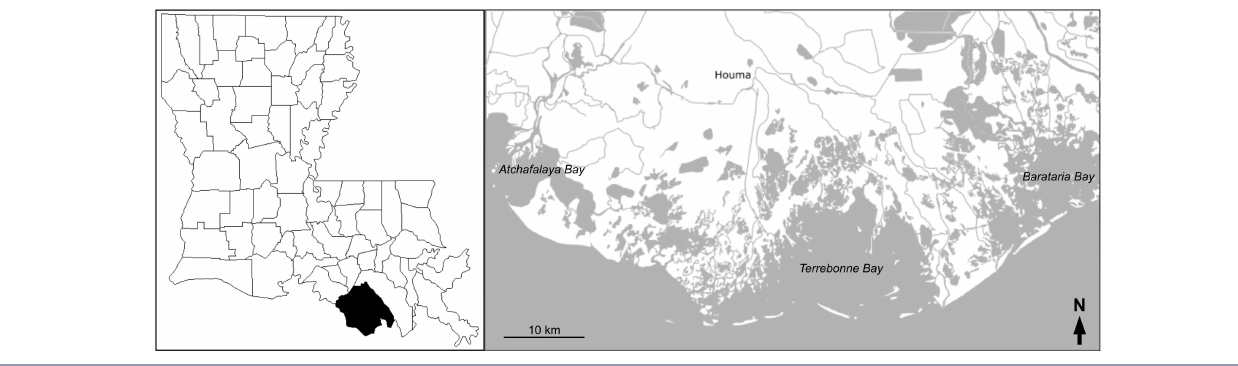
Fig. 1. Location of Terrebonne Parish, Louisiana, USA, including Houma, the location of the parish